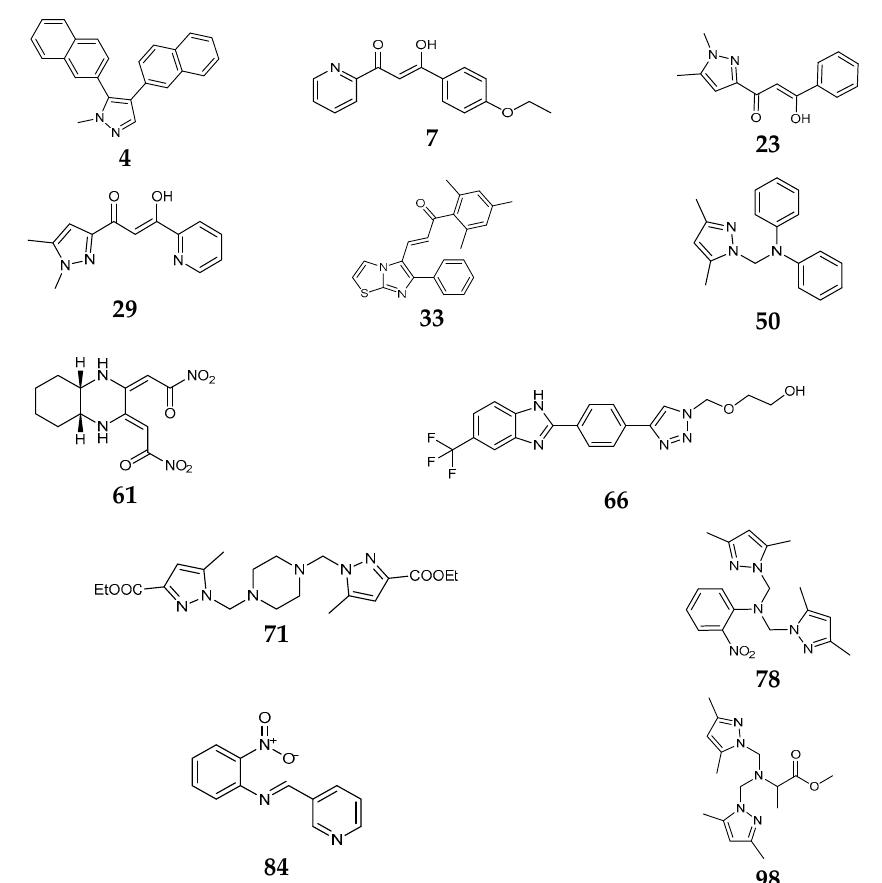
Figure 2. Chemical structure of the best active compounds from the group. As presented in Figure 2, compounds 7 , 23 , 29 , and 61 have the antifungal